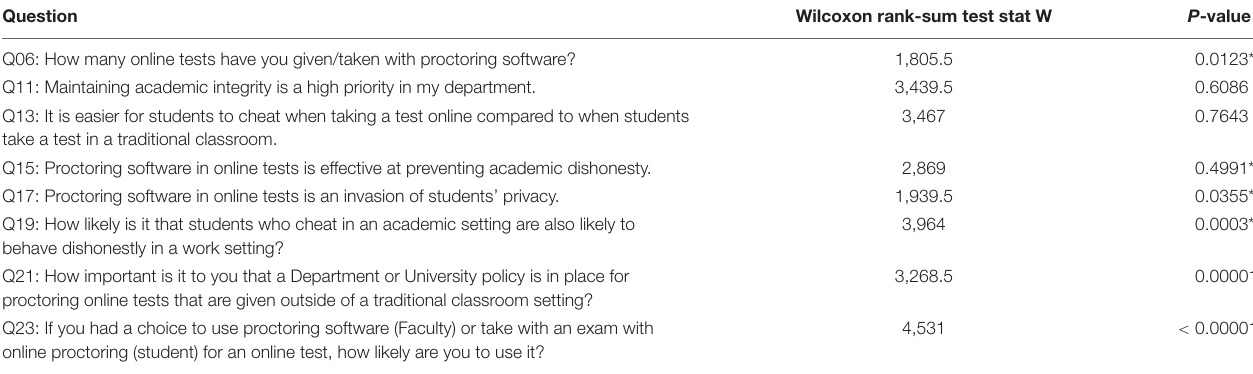
TABLE 1 | Wilcoxon rank sum and p -values for Likert scale questions. Question Wilcoxon rank-sum test stat